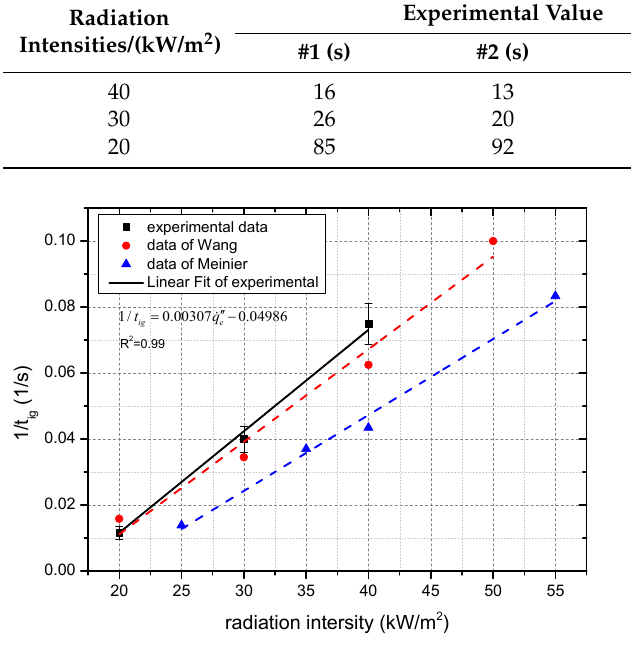
Figure 4. XLPE (1/ t ig ) and external heat flux diagram.